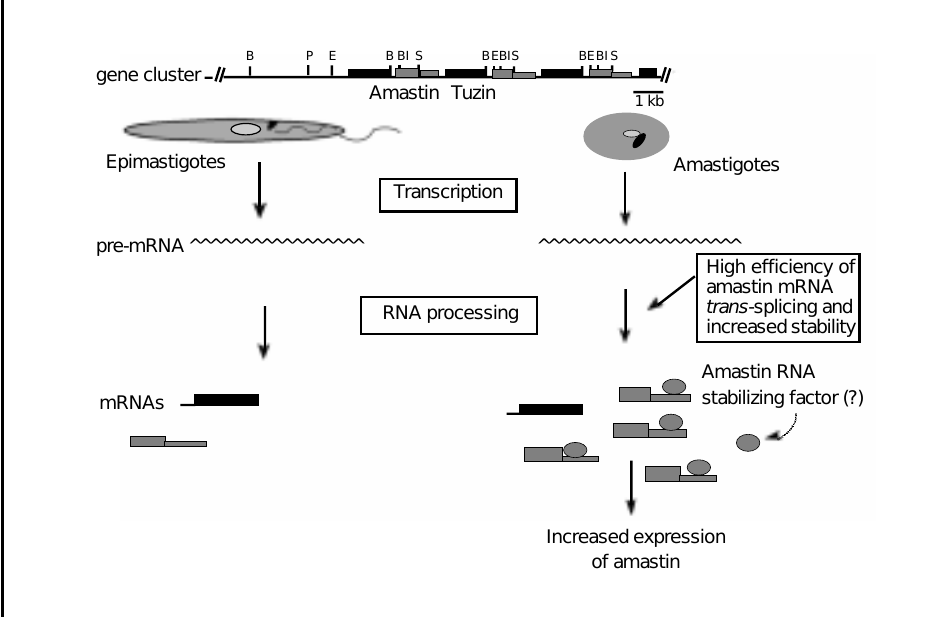
Figure 3 - A model for the regula- tion of amastin gene expression in T. cruzi . The amastin/tuzin gene cluster is shown, with dark and gray boxes representing copies of tuzin and amastin genes, respectively. Intergenic regions are shown as thin lines (The diagram including the re- striction sites was modeled af- ter Teixeira et al. (43)). Polycis- tronic transcription, which oc- curs at the same rates in amasti- gotes and epimastigotes, gener- ates a pre-mRNA (wavy lanes) that needs to be processed in order to produce mature mRNA encoding amastin (gray box) and tuzin (dark box) proteins. The dif- ferential accumulation of these mRNAs in the two forms of the parasite’s life cycle may be de- pendent upon at least two fac- tors: higher efficiency of amastin mRNA processing and increased stability of the mRNA in amasti- gotes. An RNA-binding protein, which is more abundant in amas- tigotes, is proposed to be in- volved in the regulatory pathway through specific binding at the 3’UTR of amastin mRNA